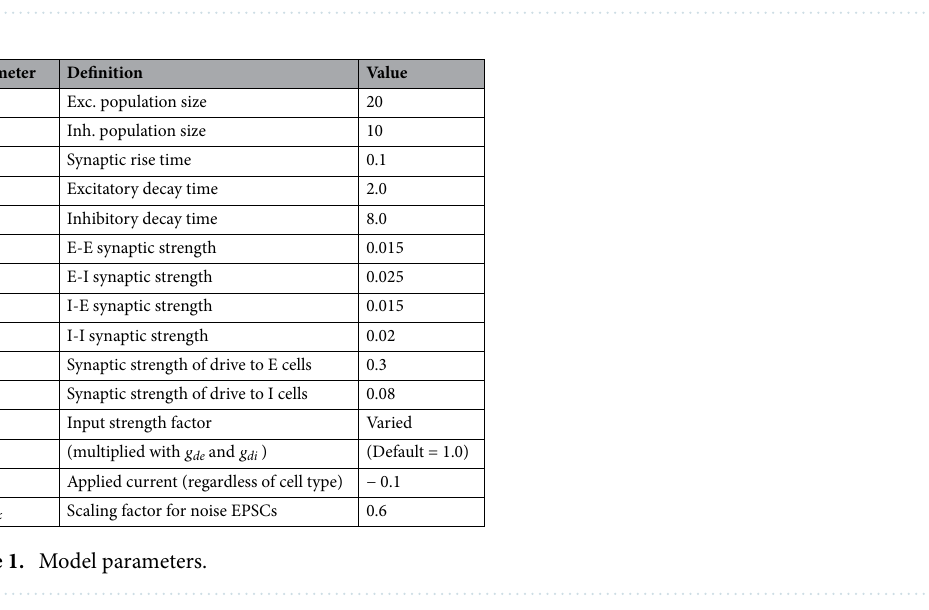
Figure 8. ( a ) Network schematic showing the two neural populations (excitatory pyramidal cells and inhibitory basket cells) and their connectivity. Additionally, both populations receive periodic ASSR input drive and random background noise. ( b ) Three potential microscopic changes underlying gamma ASSR deficits were implemented: Increased IPSC decay times at inhibitory synapses onto PCs, decreased GABA levels resulting in reduced IPSC amplitudes at inhibitory synapses onto PCs, NMDAR hypofunction resulting in decreased excitability of GABAergic interneurons. ( c ) Depiction of a 40 Hz click-train stimulus, where tones (synchronous inputs to the cells of the network) are presented with an inter-click interval of 25 ms resulting in a drive frequency of 40 Hz. ( d ) Example simulated MEG signal of the network in response to a 40 Hz click-train stimulus.